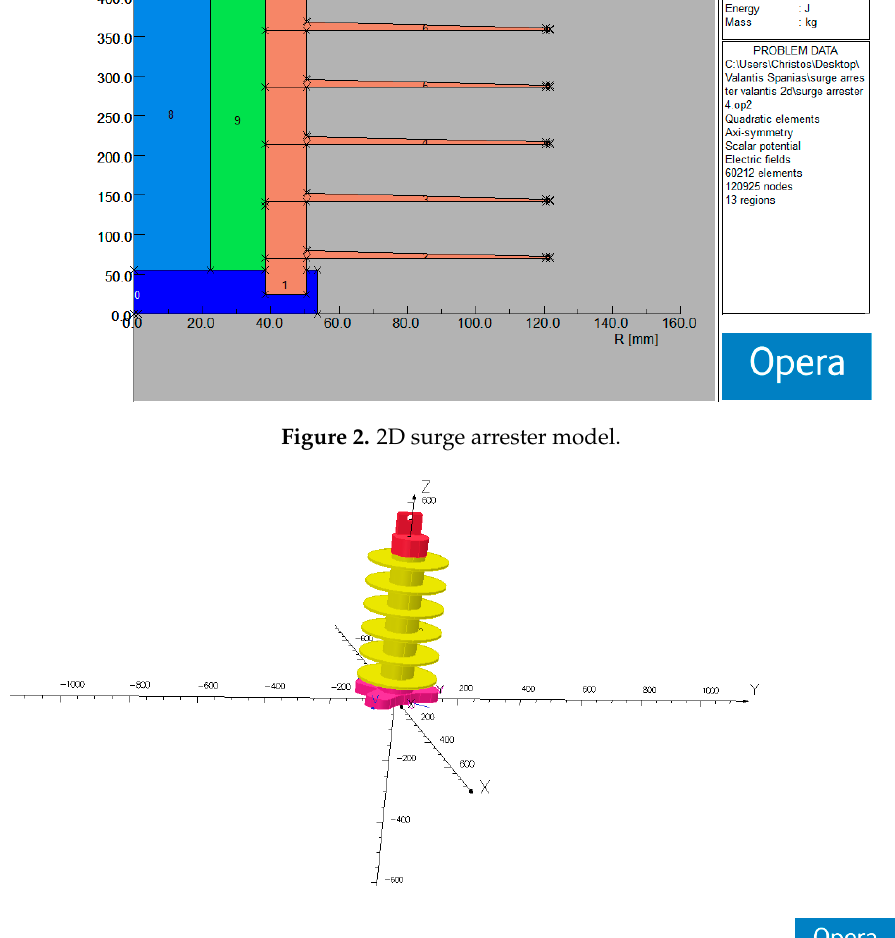
Figure 3. 3D surge arrester model.